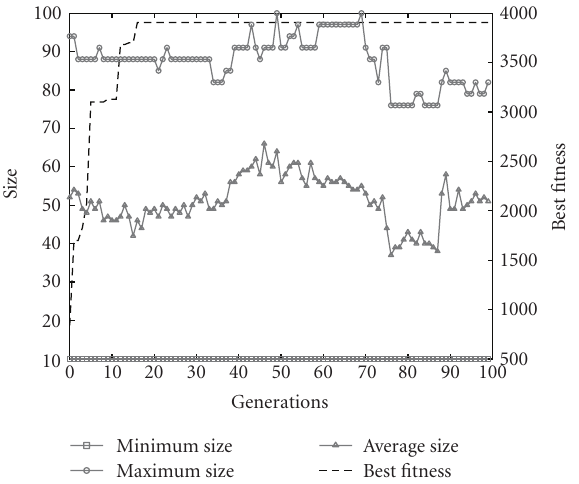
Figure 16: Parameter optimization Experiment 2: chromosome sizes and best fitness.